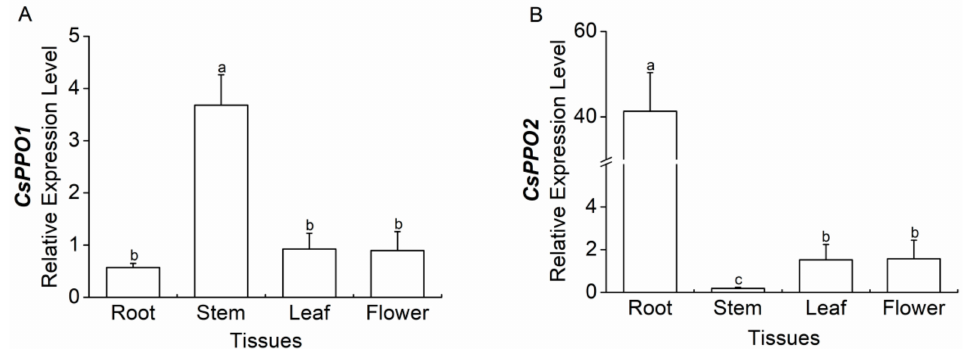
Figure 4. Mean levels of transcriptional expression ( ± SE) of ( A ) CsPPO1 and ( B ) CsPPO2 in tissues from the roots, stems, leaves, and flowers of Camellia sinensis . CsGAPDH was used as a reference gene. For each column, different letters indicate significant differences among tissues ( p < 0.05, Duncan’s multiple range test, n =